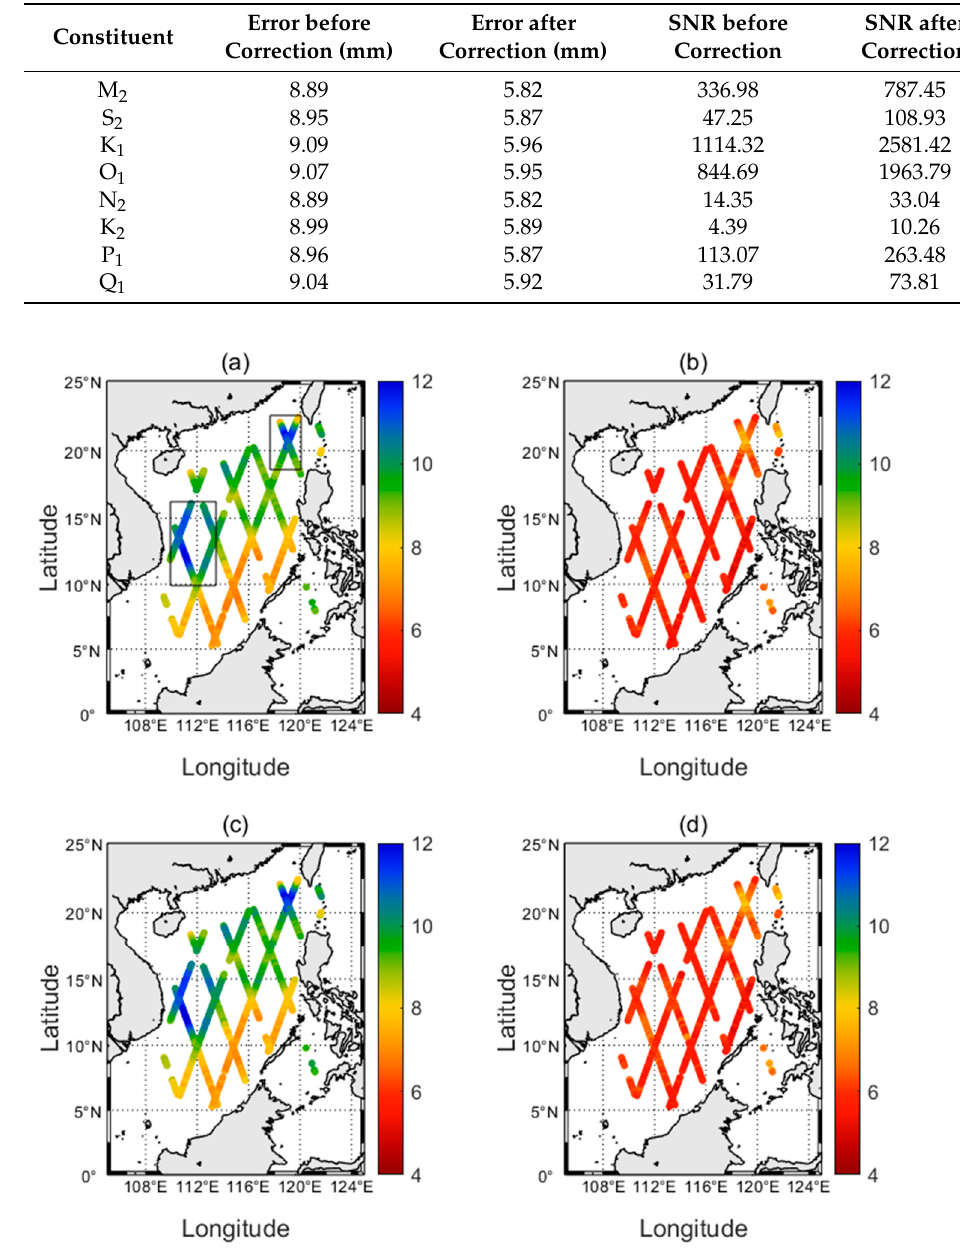
Table 3. Comparison of the space-averaged error and SNR of eight main tidal constituents before and after the MVC in the South China Sea.